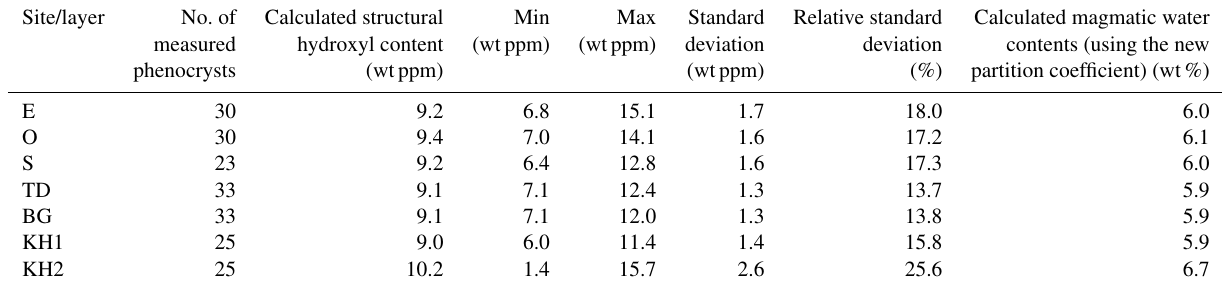
Table 3. The calculated structural hydroxyl and magmatic water content for each layer and the main statistical indicators.